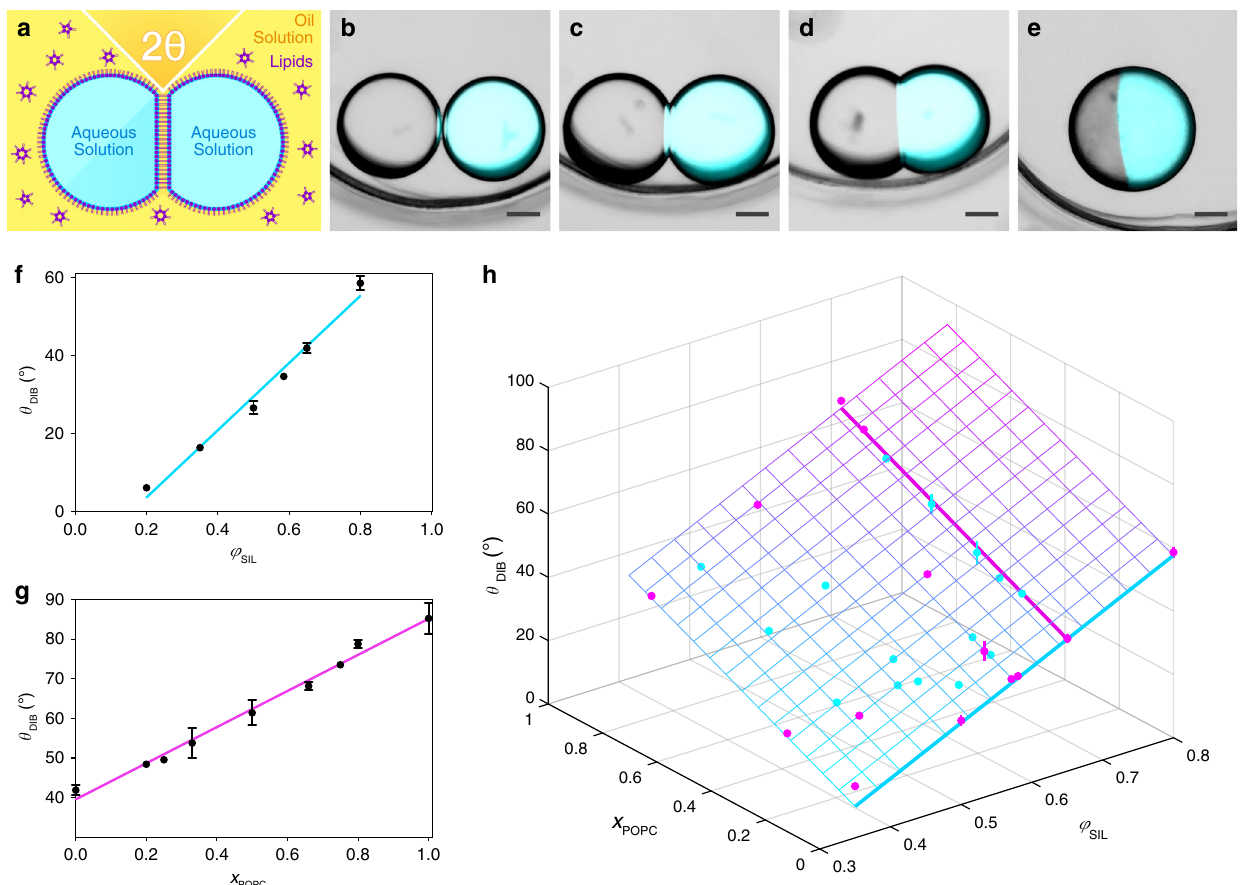
Fig. 1 The contact angle depends on the lipid and oil compositions. a Schematic of a pair of aqueous droplets forming a droplet interface bilayer (DIB) in a lipid-in-oil solution, and the de fi nition of the equilibrium contact angle ( θ DIB ). b – e Bright- fi eld and fl uorescence microscopy overlays of droplet pairs formed with 1 mM DPhPC and φ SIL values of 0.20 ( θ DIB = 6.0 ± 0.7°) ( b ), 0.50 ( θ DIB = 26.5 ± 1.7°) ( c ), 0.80 ( θ DIB = 53.4 ± 0.8°) ( d ) and with 1 mM POPC and φ SIL = 0.65 ( θ = 85.3 ± 3.8°) ( e ). Scale bars = 150 µ m. In each image, the right droplet contains 10 µ M Atto488 to demonstrate that a bilayer has formed DIB and compartmentalises the bilayer-impermeant dye. f A plot showing the linear dependence of θ DIB with respect to φ SIL for 1 mM DPhPC (linear regression R 2 = 0.99) (see Supplementary Table 1). g A plot showing the linear dependence of θ x φ = 0.65 (linear regression R 2 = 0.99) DIB with respect to POPC at SIL (see Supplementary Table 2). h A plot of the 2D linear dependence of θ DIB with respect to both φ SIL and x POPC (regression plane R 2 = 0.99) (see Supplementary Table 8). The total lipid concentration was 1 mM. Data points that lie above and below the regression plane are in magenta and cyan, respectively. For all experiments, the aqueous phase was PBS at pH 7.2. Each data point in f – h is the mean of n > 3 contact angle measurements, and the error bars represent the standard deviation. When error bars are not visible, they have standard deviations smaller than the data symbols. For individual n values, see Supplementary Table